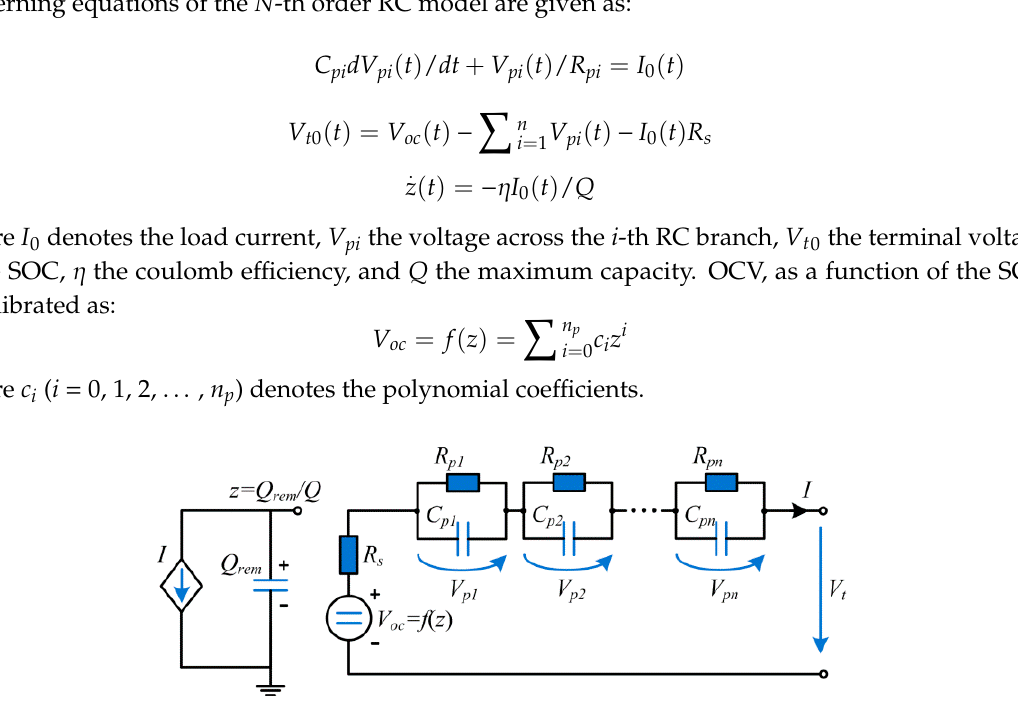
Figure 1. General structure of the N -th order RC model (the ellipsis represents repeated RC branches connected in series).